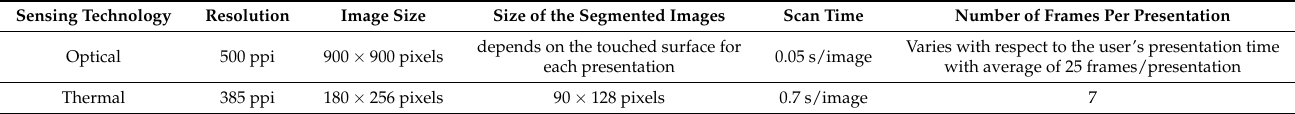
Table 4. Comparison between the characteristics of the sensors and presentations in the database.